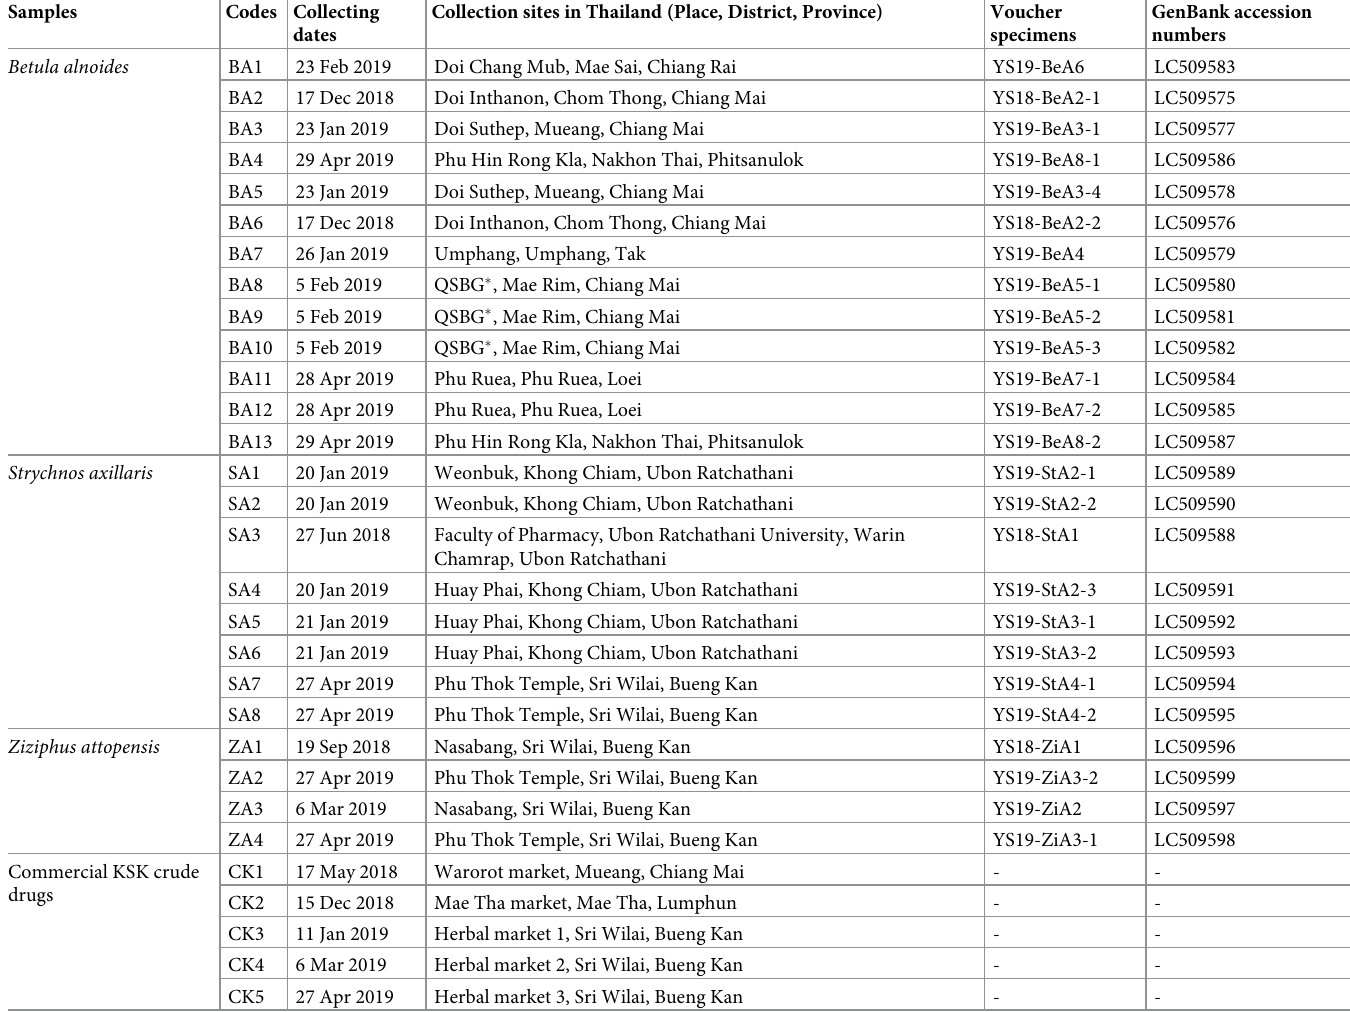
Table 1. List of authentic plants and commercial KSK crude drugs collected from different areas in Thailand.